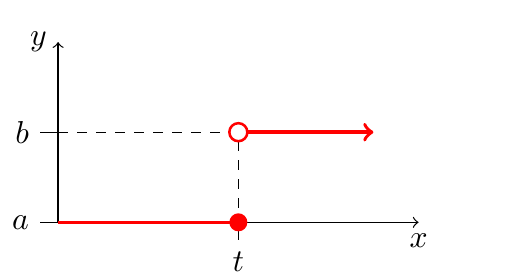
Figure 2. Definition of the ramp function. ( Right ) A mathematical definition of an increasing ramp function as used in our workflow. Parameters a and b are usually set to values 0 and 1, respectively; and vice versa for decreasing version. Values t 1 and t 2 typically represent some significant thresholds on x . ( Left ) Graphical description of the same function.